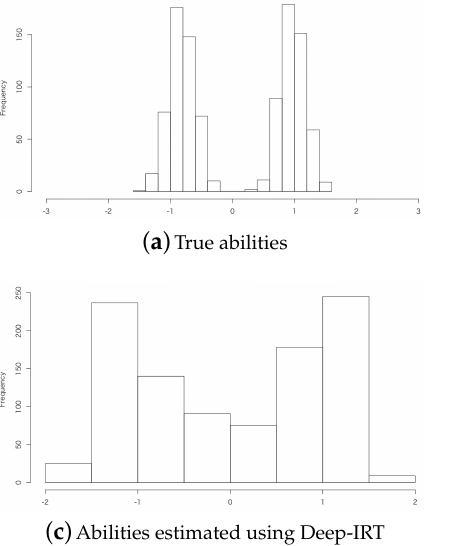
Figure 3. Histograms of estimated abilities for multi-population